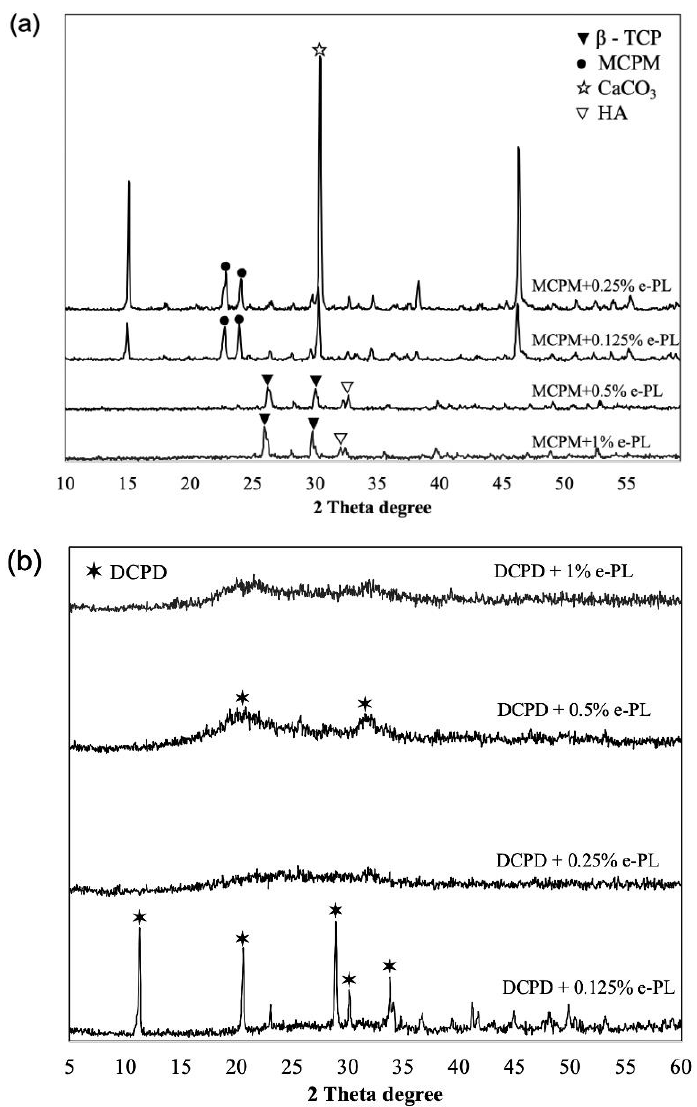
Figure 3. XRD patterns of MCPM ( a ) and DCPD ( b ) mixed with ε